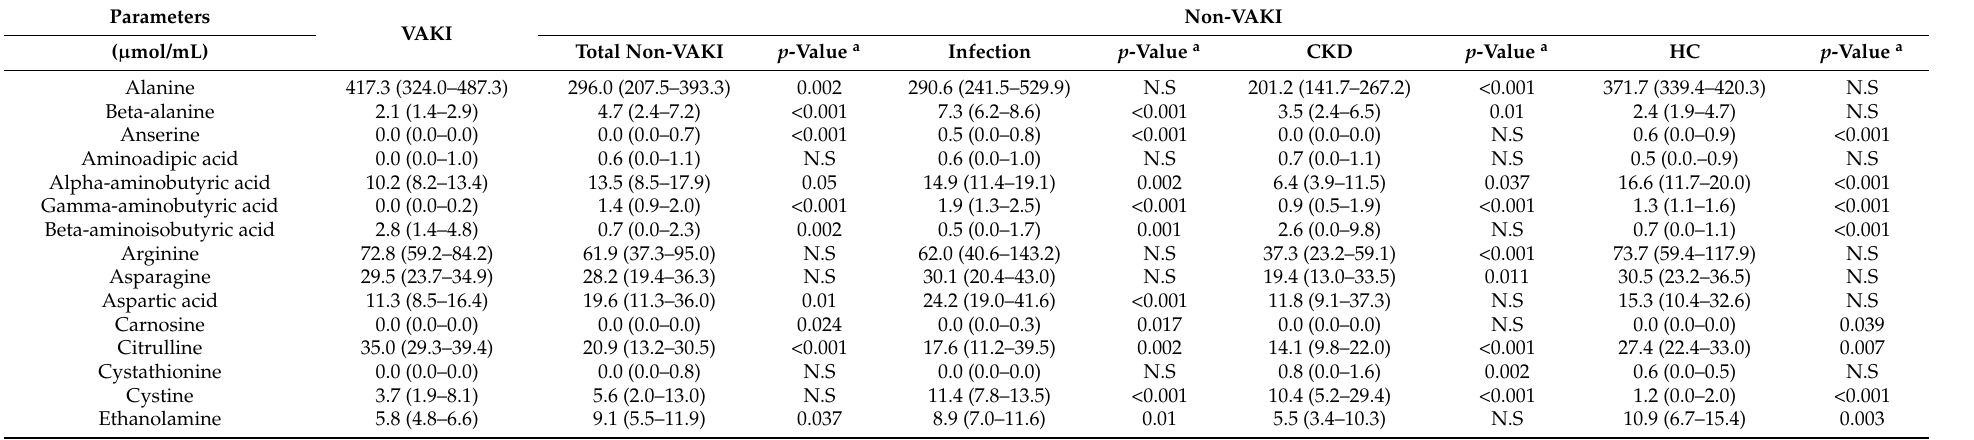
Table 2. Comparison of serum amino acids and amino acid derivatives concentration between VAKI group and non-VAKI